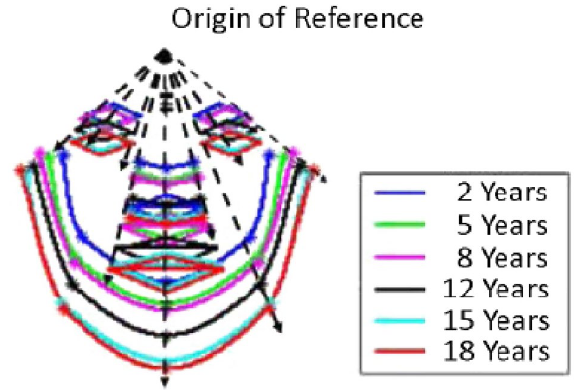
Figure 2. Cranio-facial changes during the first phase of aging.